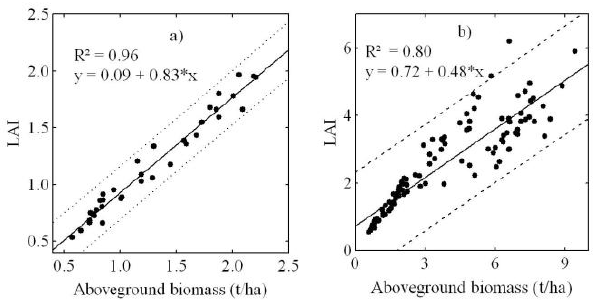
Figure 2. Relationship between AGB and LAI for the stem elongation stage 2009 (a) and all available stages 2009 (b) with p = 0.99 for the confidence bands 3.3 Relationship between AGB and reflectances at single wavelengths The coefficients of determination (R²) between AGB and the 1450 individual narrow bands were plotted for the single several years and across all years in Fig. 3. The noise of water absorption bands was excluded. In general, the relationship sensitive wavelengths. The largest R² values (> 0.4) were